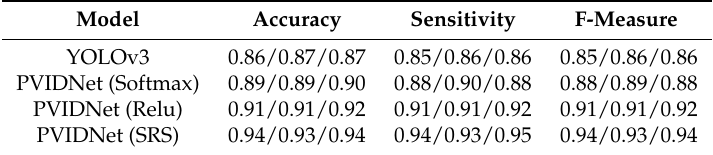
Table 6. Results of the DL algorithms to classify the images of buses (right/left/front) in the training